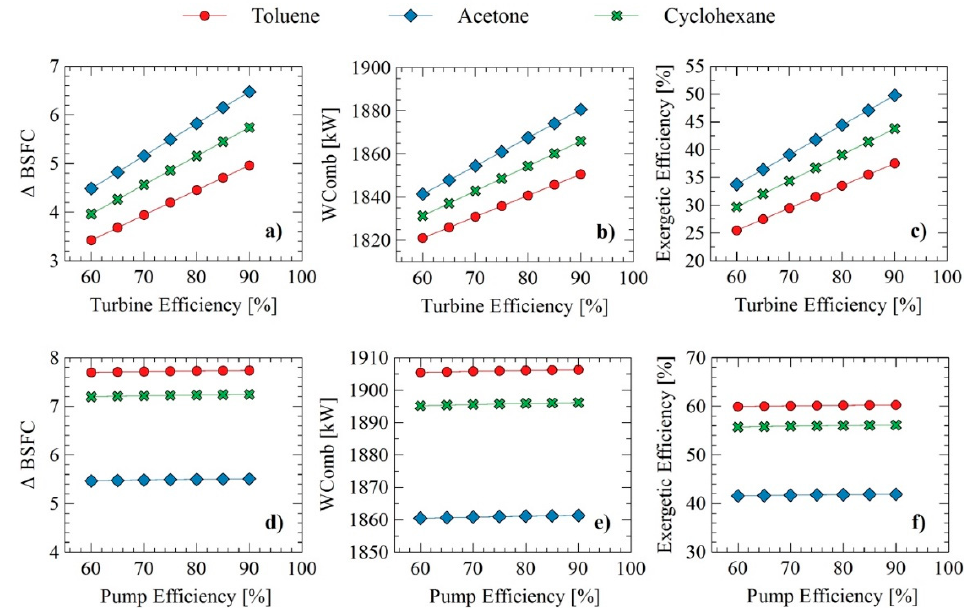
Figure 3. E ff ect of turbine and pump e ffi ciency variation on ( a , d ) specific fuel consumption ( ∆ BSFC), Figure 3. Effect of turbine and pump efficiency variation on ( a , d ) specific fuel consumption ( ∆ BSFC), ( b , e ) Wcomb, and ( c , f ) exergetic e ffi ciency using toluene, acetone, and cyclohexane as working ( b , e ) Wcomb, and ( c , f ) exergetic efficiency using toluene, acetone, and cyclohexane as working fluids.